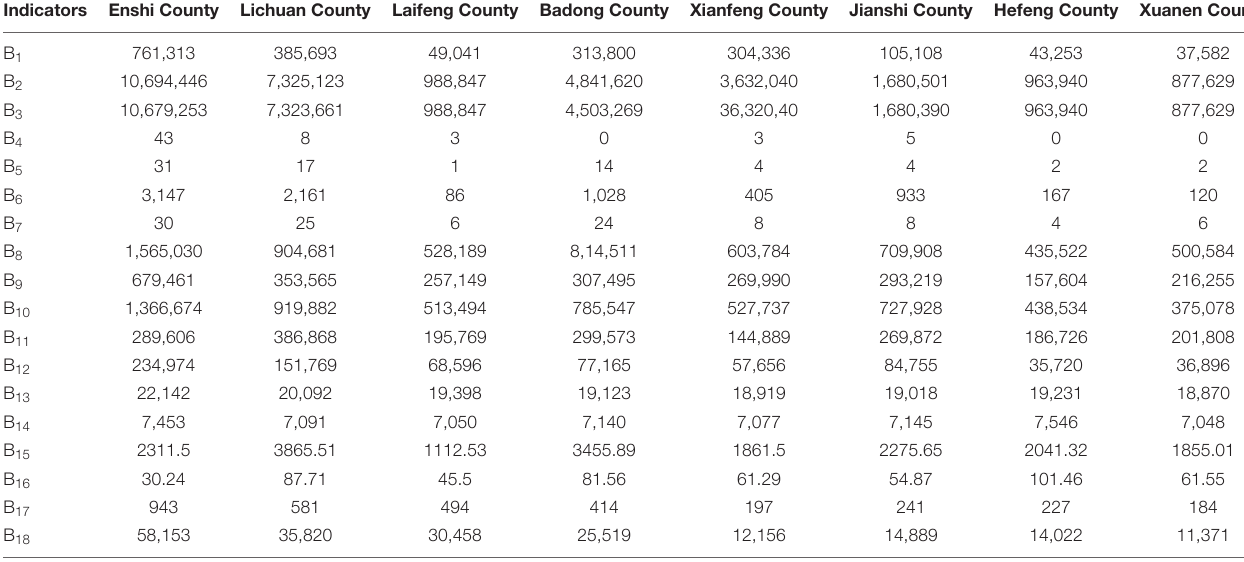
TABLE 2 | Indicators of EAP mountain tourism competitiveness.